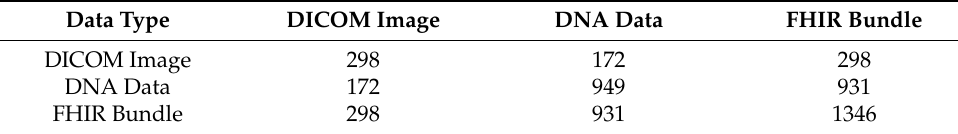
Table 2. Count of synthetic patients with two or more data files.